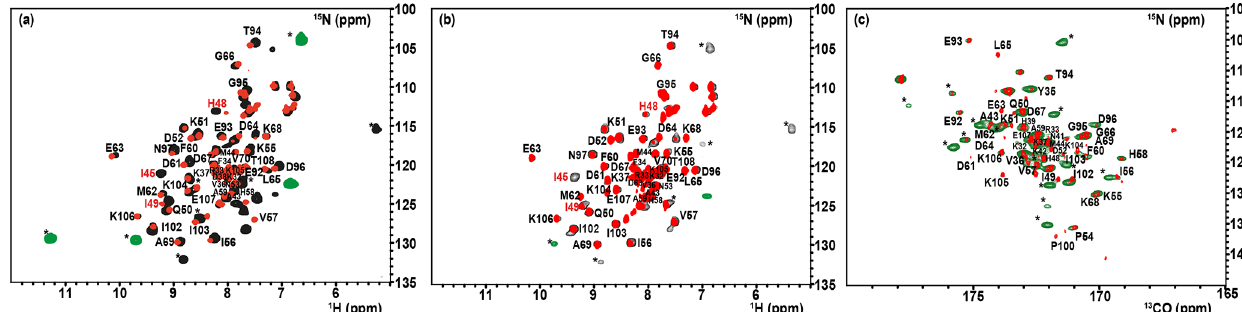
Figure 3. Overlap of the diamagnetic HSQCs (red) and paramagnetic-tailored 15 N-IR-HSQC-AP (positive peaks: black/negative: green) for the oxidized (a) and reduced (b) forms of mitoNEET. (c) Overlap of diamagnetic (red) and paramagnetism-tailored (green) CON ex- periments for the reduced state of mitoNEET. Peaks labeled with asterisks are those that are observed only in the paramagnetic-tailored experiments. Peaks observed but not assigned are labeled with X. Red-colored assignments refer to signals that are only barely detectable in the diamagnetic experiments and could be sequentially assigned only in the paramagnetic-tailored